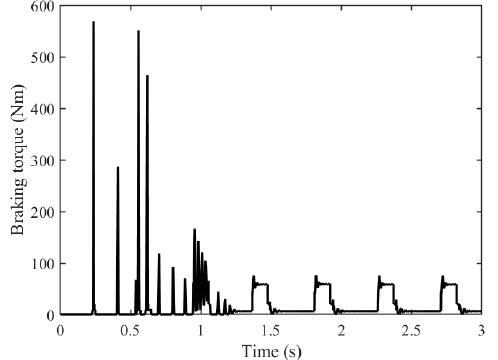
Figure 16. Axial displacement of steel ball and connecting shaft.